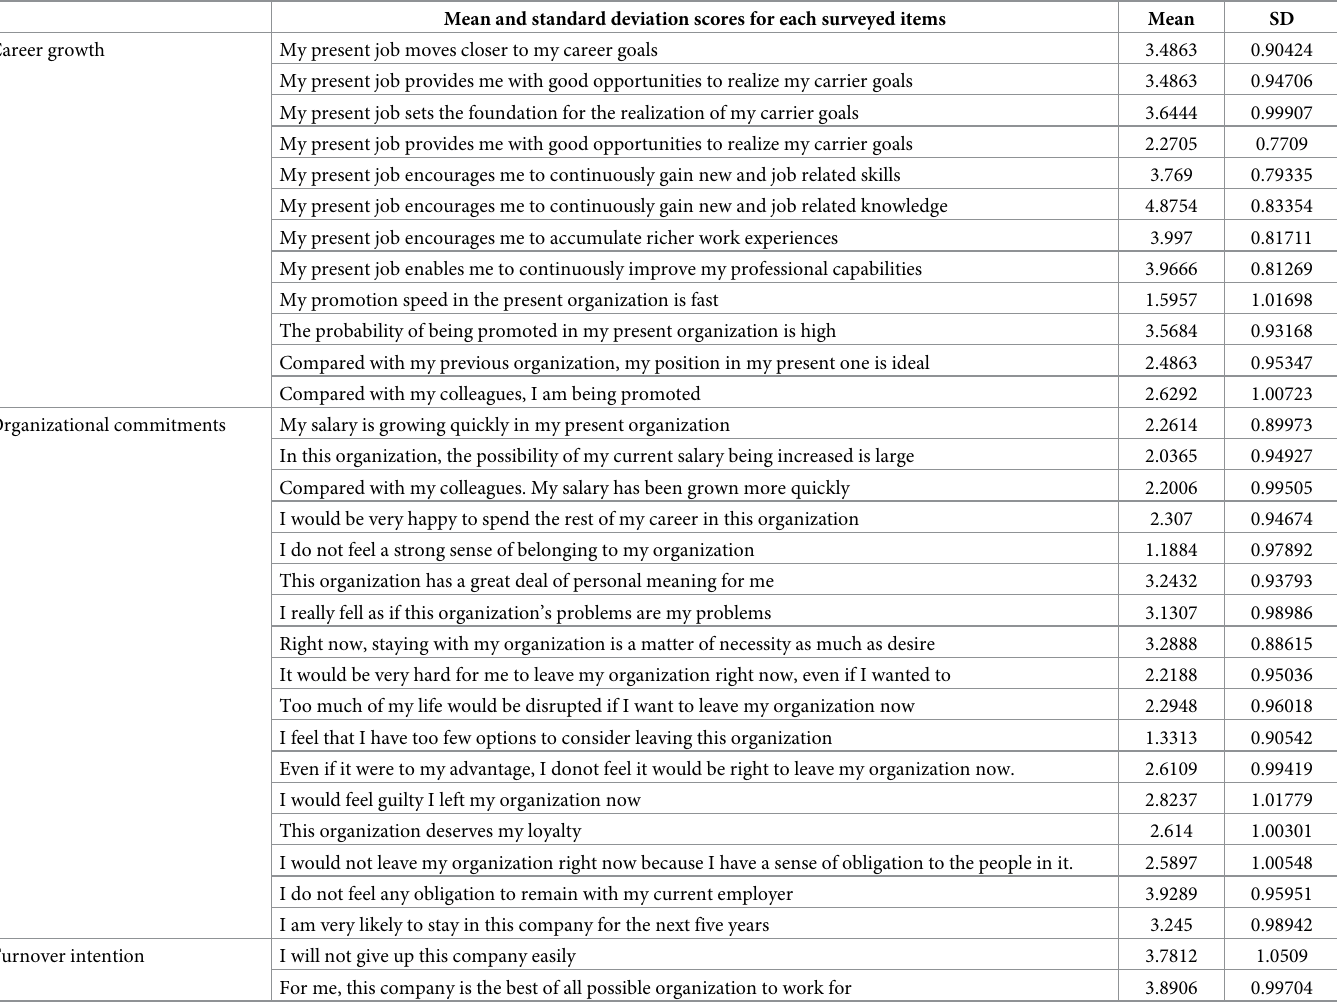
Table 10. Mean and standard deviation scores for each surveyed